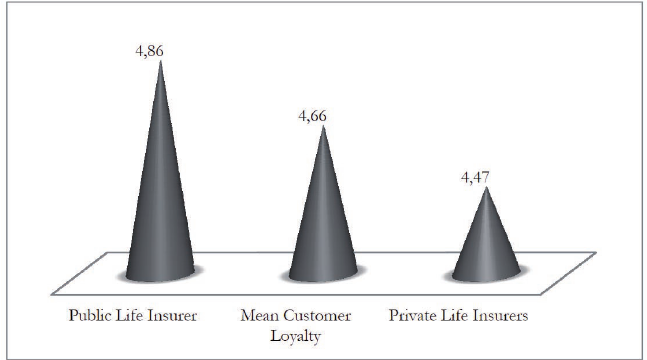
Fig. 4 - Customer Loyalty in Life Insurance. Source: own